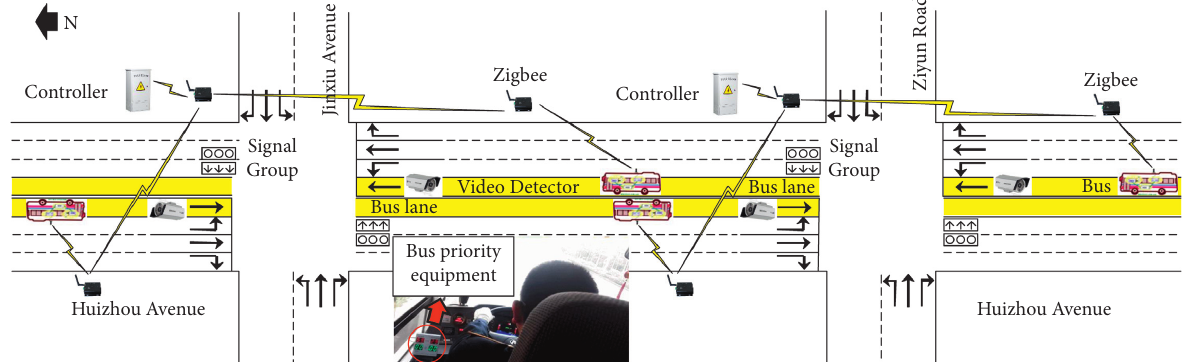
Figure 3: Infrastructure condition for bus signal priority control at the test intersections.